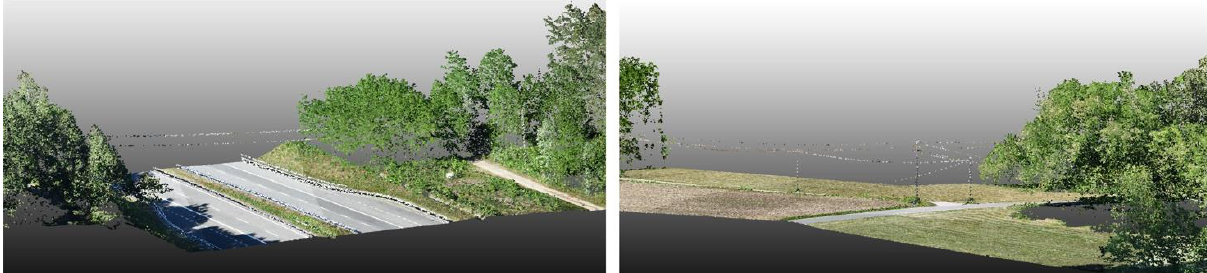
Figure 6. Two details of the 3D point clouds generated over the power line corridor (left: MT 1, right: MT 2).